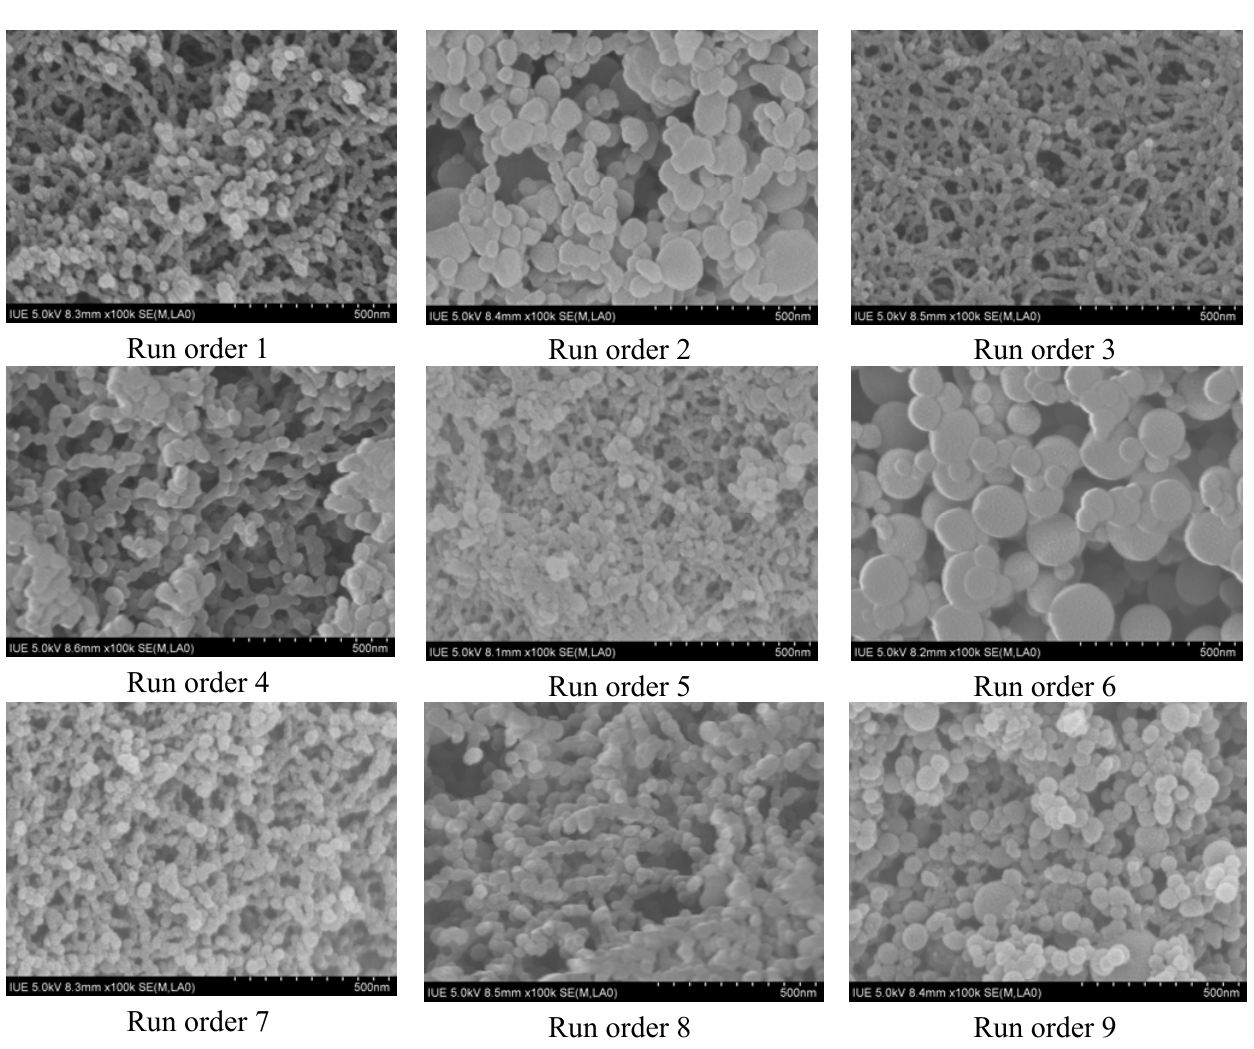
Figure 2. SEM photographs of PVM/MA nanoparticles obtained in different run orders as shown in Table